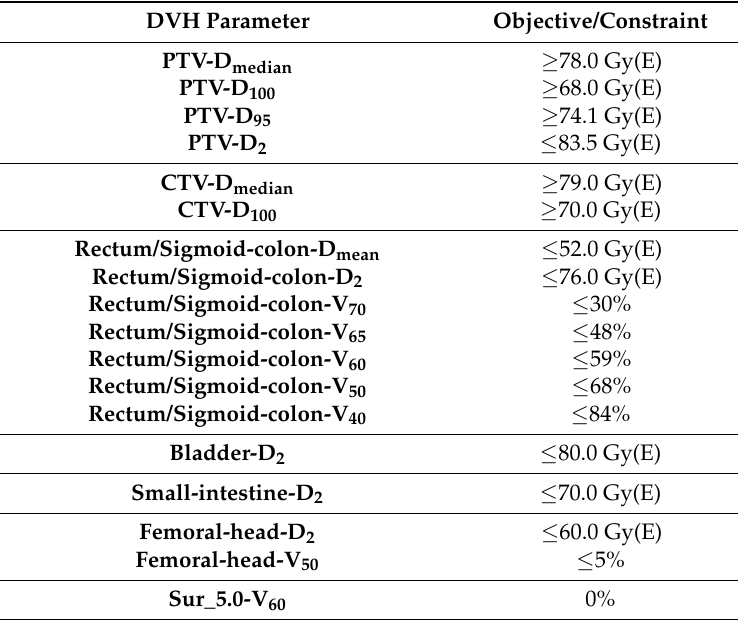
Table 1. Dose Volume Histogram criteria for plan